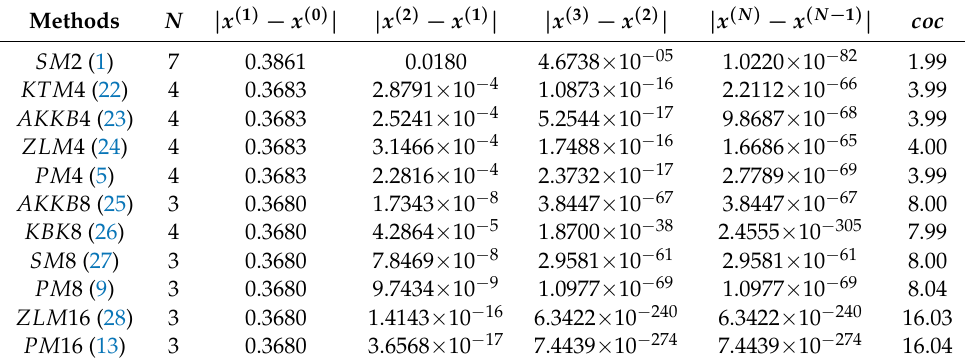
Table 3. Comparisons between different methods for f 3 ( x ) at x ( 0 ) = 2.7.